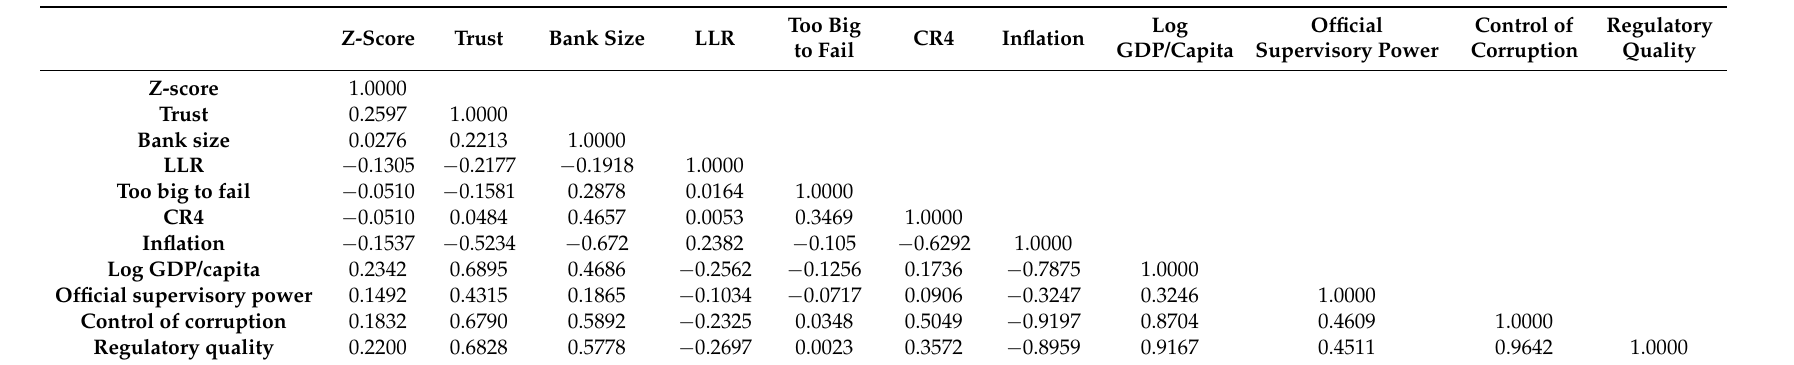
Table 2. Correlation matrix of main regression variables—Trust.